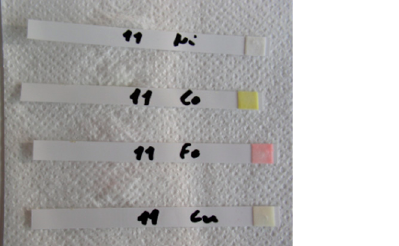
Figure 15. Screening test. White ceramic watch link.